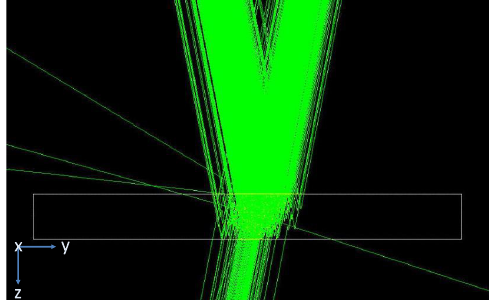
FIG. 3. A snapshot of the light-matter interactions in the GEANT 4 simulation. The green line is the x-rays. The white box is the frame of the crystal. A large part of incident x-rays is reflected, with crystal thickness of 70 μ m, photon energy of 14.33 keVand Bragg angle of about 83°. The incident direction of the x-rays points to the negative value of the z-axis.